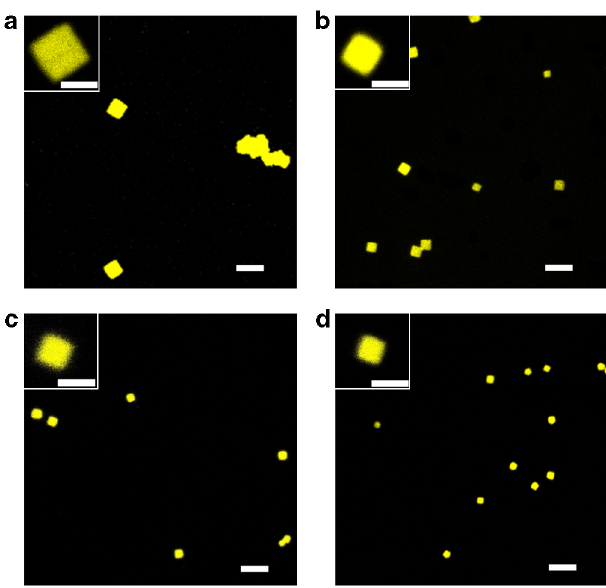
Fig. 4 LSCM images of fl uorescent platelet 2-D square micelles. LSCM images of representative samples of 2D square micelles in a 0.01 mg ml − 1 2-PrOH solution of PPV 12 - b -P2VP 12 ; b 0.005 mg ml − 1 2-PrOH solution of PPV 12 - b -P2VP 12 ; c 0.01 mg ml − 1 2-PrOH solution of PPV 12 - b -P2VP 16 , and d are 5 μ m, whereas those of insets are 2 μ